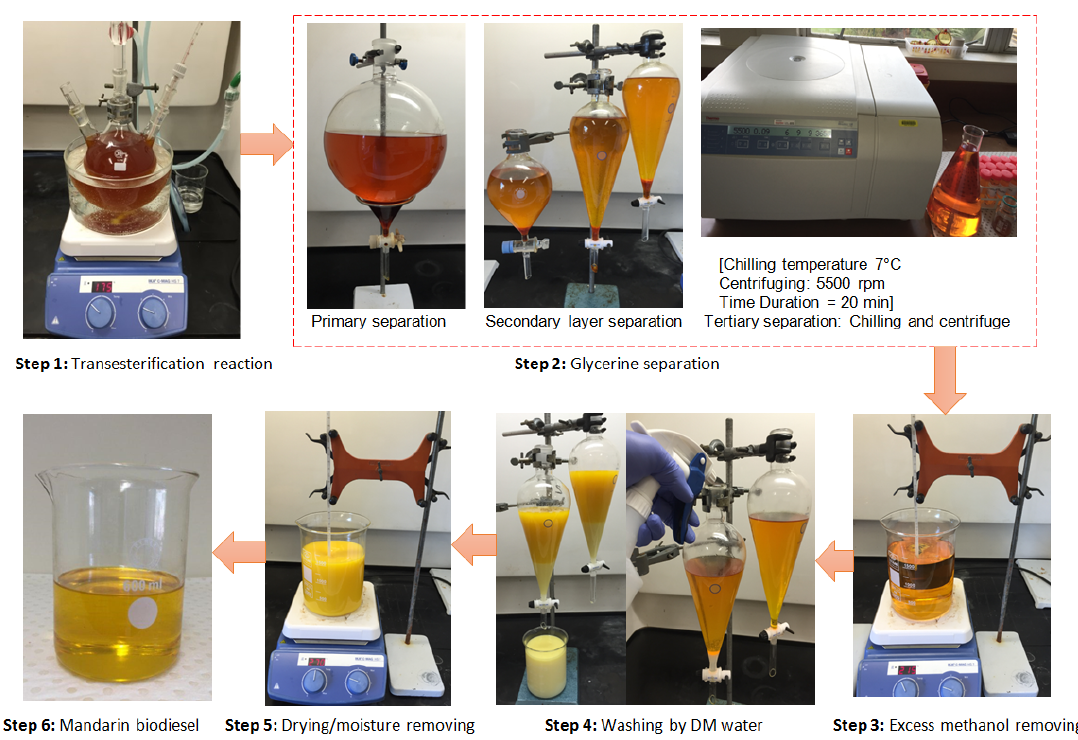
Figure 4. Mandarin biodiesel conversion by transesterification reaction.